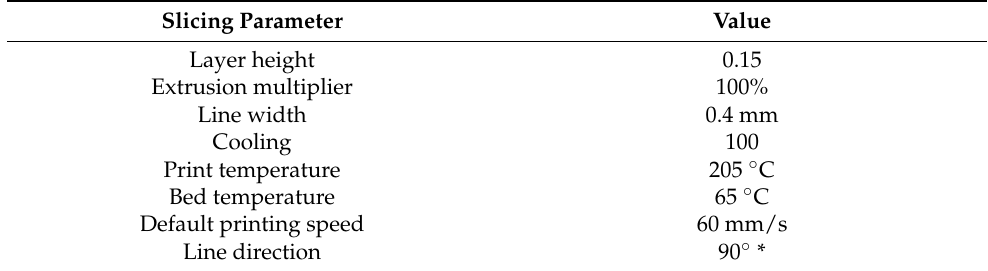
Table 1. Slicing